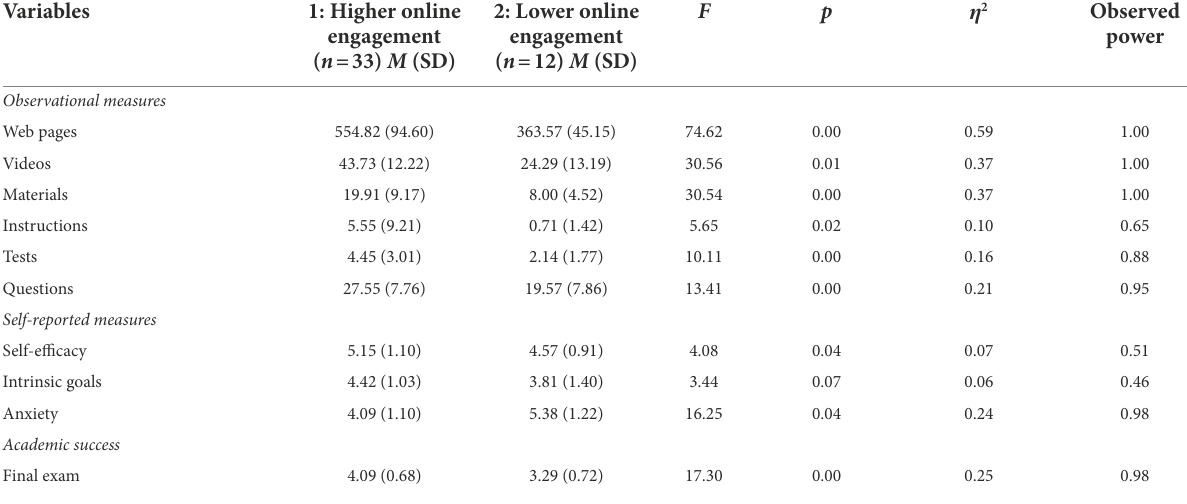
TABLE 4 Hierarchical cluster analysis using the observed students’ interactions with online learning